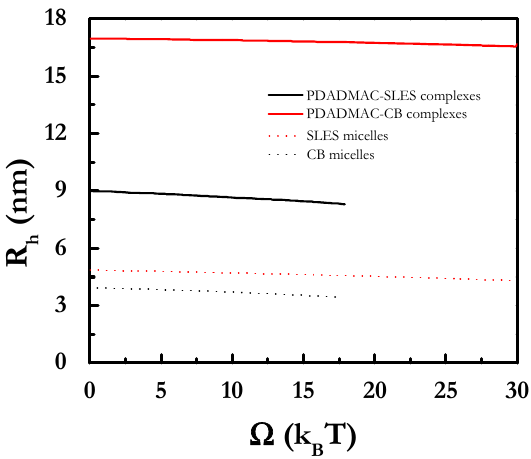
Figure 5. Grand potential Ω dependences of the hydrodynamic radius, R h , for the polymer–surfactant complexes and the surfactant micelles in absence of polyelectrolyte.